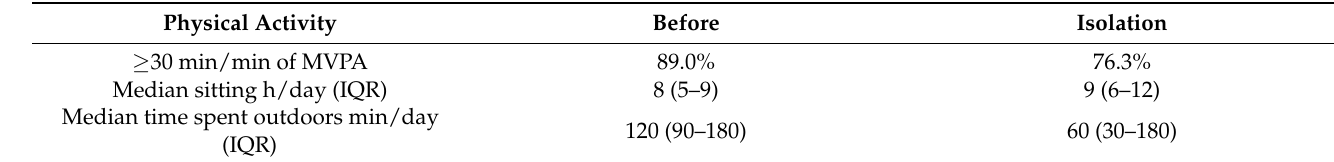
Table 2. Change in physical activity patterns before and during